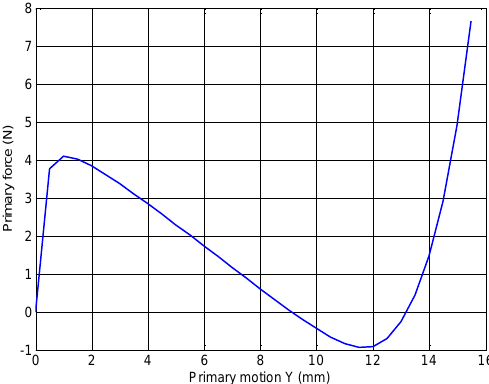
Figure 3. Load-displacement relation in the primary direction for the case